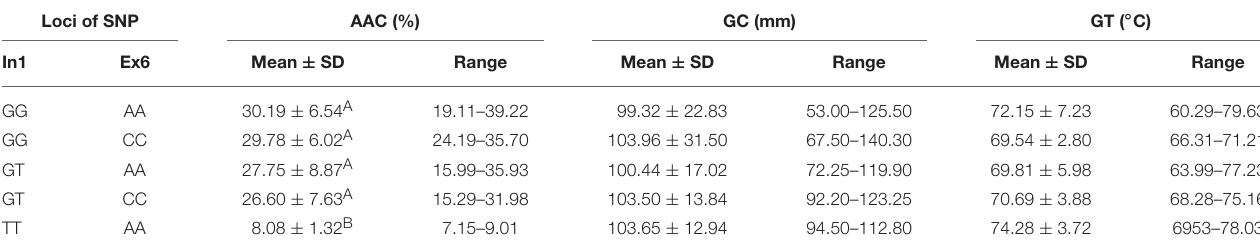
TABLE 4 | ECQs for different haplotypes of In1G/T and Ex6A/C polymorphisms of Wx . Loci of SNP